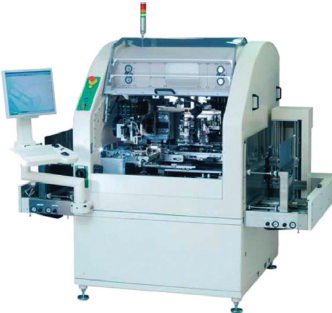
Figure 2: Mechanism of die bonding.